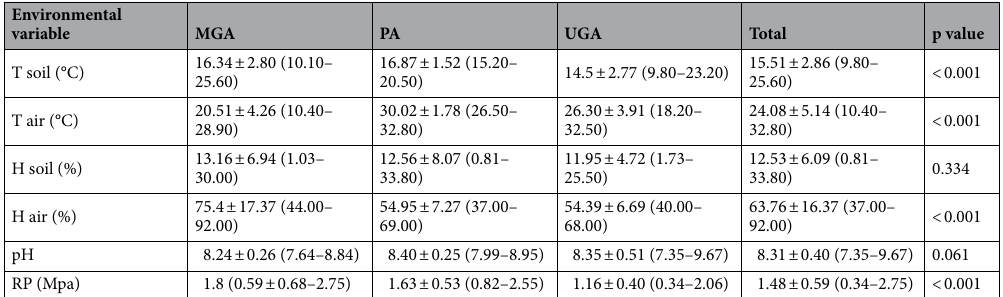
Table 1. Mean ± standard deviation (range) of the environmental variables for the different categories of management regime in urban areas. The p value represents the significance level of the global one-way analysis of variance performed separately for each environmental